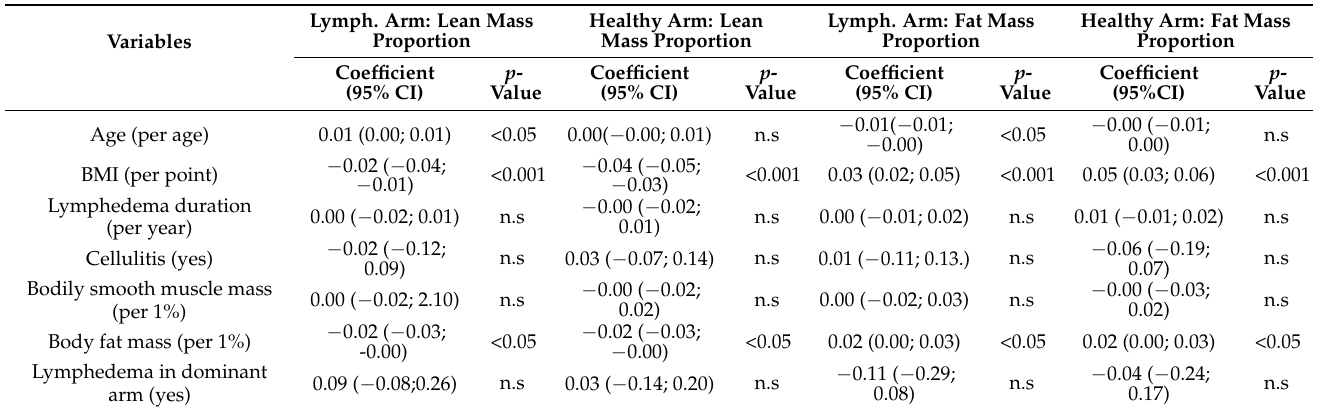
Table 3 legend: This table shows the multivariate beta regression models for fraction of arm mass comprised of fat and lean mass in the healthy and lymphedema arm. Increase in BMI and body fat mass was associated with a higher fraction of fat and lower fraction of lean mass in both the healthy and lymphedema arm. N.s = not significant. Lymph = lymphedema. N.s = not